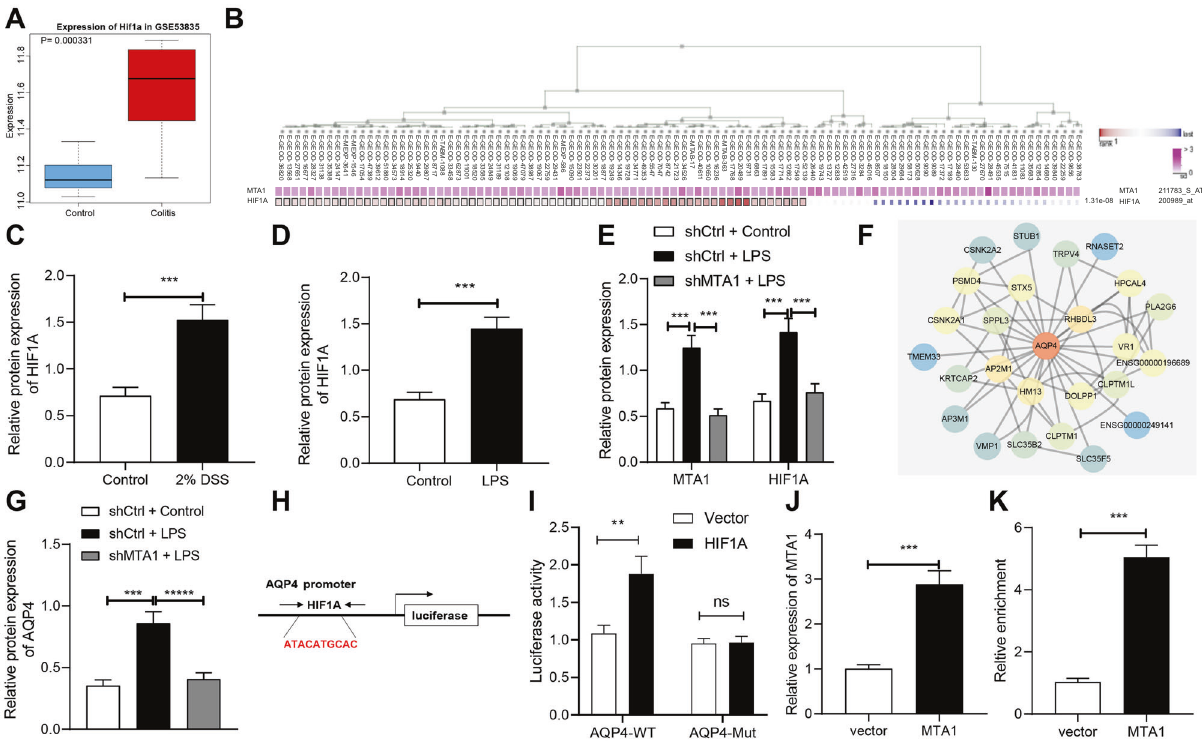
Fig. 3 MTA1 upregulates the expression pattern of HIF1A to promote its transcriptional regulation of AQP4. A The expression pattern of HIF1A in the control sample (blue box) and experimental colitis sample (red box) in GSE53835 dataset. B The co-expression relationship between MTA1 and HIF1A in each dataset analyzed by MEM. (The HIF1A line in the graph was mainly red, indicating that it was mainly positive correlation). C Western blot to detect the protein expression of HIF1A in colon tissues after DSS-induced experimental colitis in mice, n = 8. D The protein expression pattern of HIF1A in FHC cells induced by LPS detected by western blot. E The protein expression pattern of HIF1A in MTA1 silenced FHC cells treated with LPS detected by western blot. F The interaction gene of AQP4 was obtained from GeneCards and the interaction network was constructed. (The red color of the gene circle suggested that the core degree of the gene in the network was higher; otherwise, the bluer the gene was, the lower the protein expression level was). G The expression pattern of AQP4 was detected by western blot after MTA1 silenced FHC cells were treated with LPS. H Schematic diagram of the binding site of HIF1A and AQP4. I Dual-luciferase reporter gene assay of correlation between MTA1 and HIF1A. J RT-qPCR validation of overexpression ef fi ciency of MTA1 overexpression plasmid in FHC cells. K The effect of MTA1 overexpression in the enrichment of HIF1A in the promoter region of AQP4 determined with ChIP assay. ** p < 0.01; *** p < 0.001. The measurement data were expressed as mean ± standard deviation. Data between two groups were compared by the unpaired student ’ s t test, and data among multiple groups were compared by one-way ANOVA, followed by Tukey ’ s post hoc tests. The experiment was conducted three times